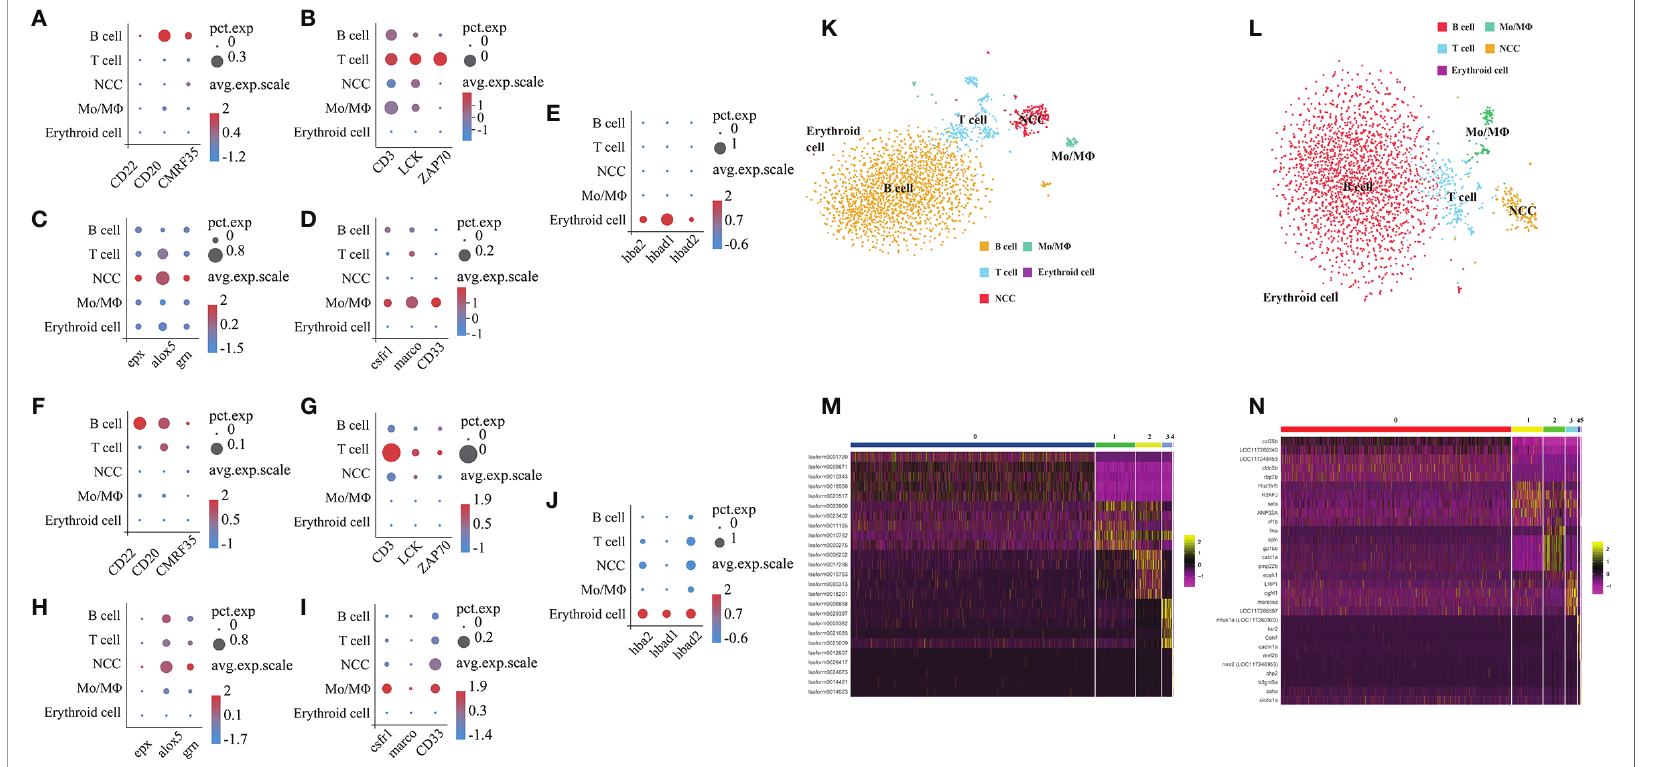
FIGURE 7 | Categorization of cell types based on full-length transcriptome and the whole E. lanceolatus genome. Bubble plots of expression of the 5 marker cell types in all clusters based on full-length transcriptome (A – E) and E. lanceolatus genome (F – J) . X-axis depicts the name of the marker gene and Y-axis the name of the cell subpopulation; the size of the bubble represents the ratio of the sum of the expression of the marker gene in a certain subgroup to the sum of its total expression (all cells); the color of the bubble represents the average expression abundance of the marker gene in the cell subgroup; the more red the bubble color, the higher the average expression of the marker gene in the respective subgroup. (K, L) Identi fi cation of 5 cell subpopulations based on marker molecules. The results based on full- length transcriptome and E. lanceolatus genome are displayed in (K, L) , respectively. The 5 cell populations are represented by different colors (B cell: orange, T cell: blue, Mo/M F : green, NCC: red). (M, N) The heatmap of the top 5 up-regulated expression genes from each cell subpopulation as a marker gene based on the full-length transcriptome (M) and E. lanceolatus genome (N)